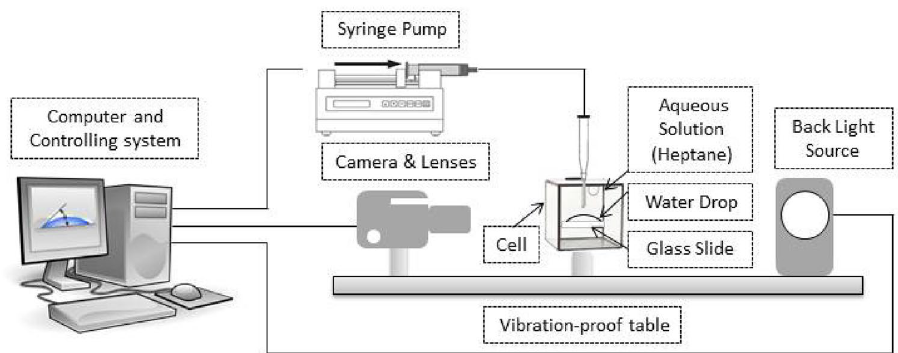
Fig. 12 Schematic diagram of the drop shape analyzer